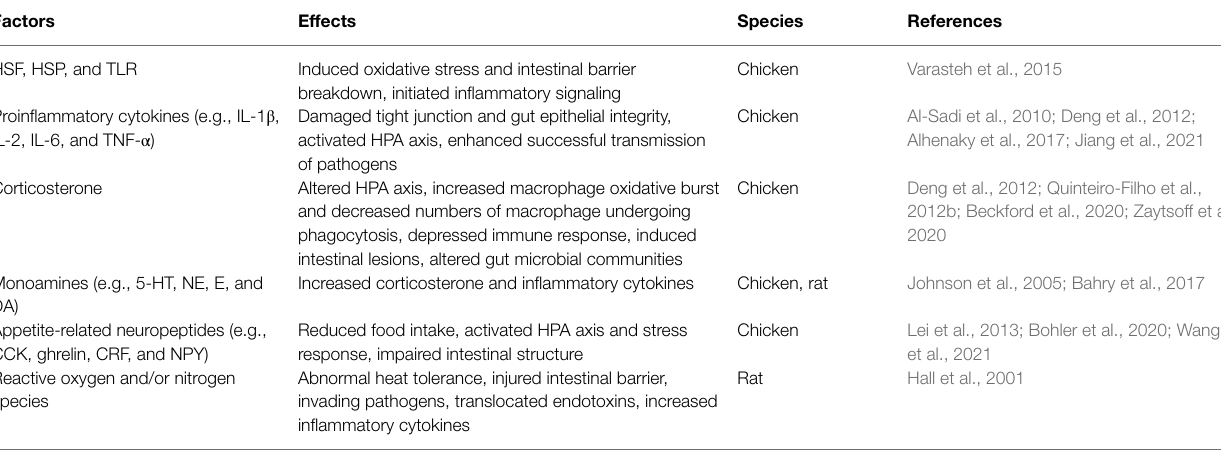
TABLE 1 | The effects of heat stress-induced neuronal/humoral factors on intestinal physiology and gut